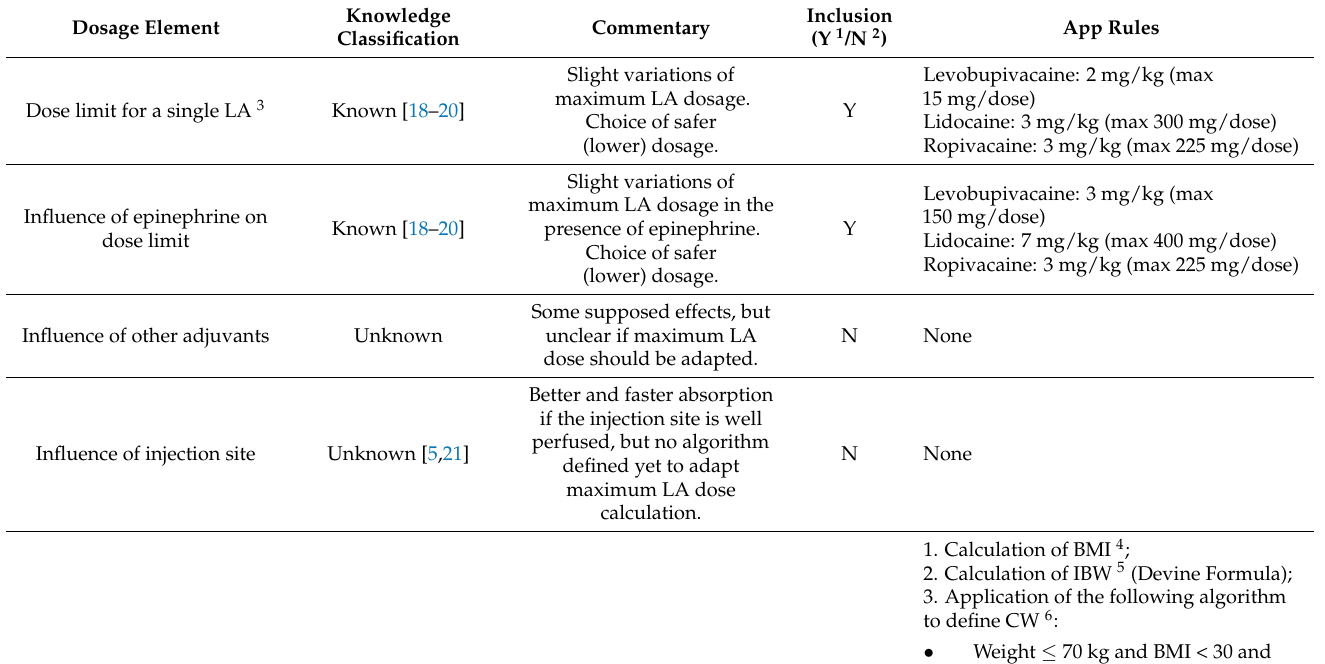
Table 3. Determination of the rules needed to calculate the maximum safe dose of local anesthetics according to scientific